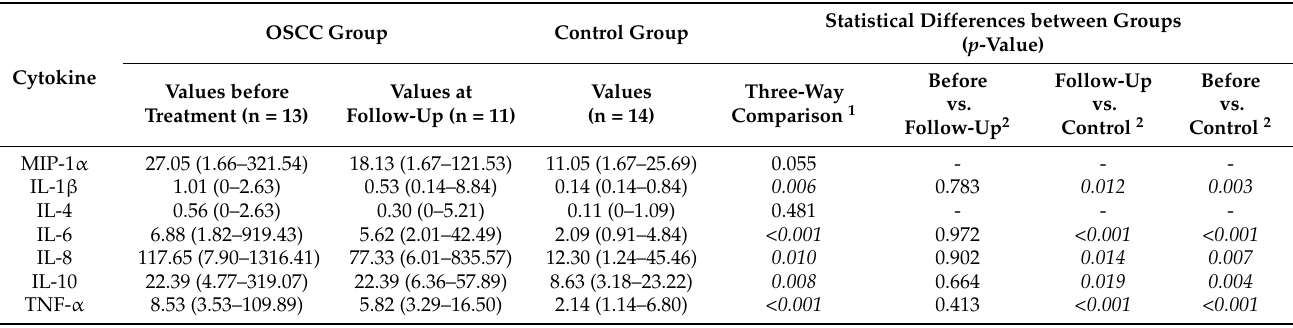
Table 3. Comparative analysis of serum cytokine levels before treatment and at follow-up with the values for the control group.